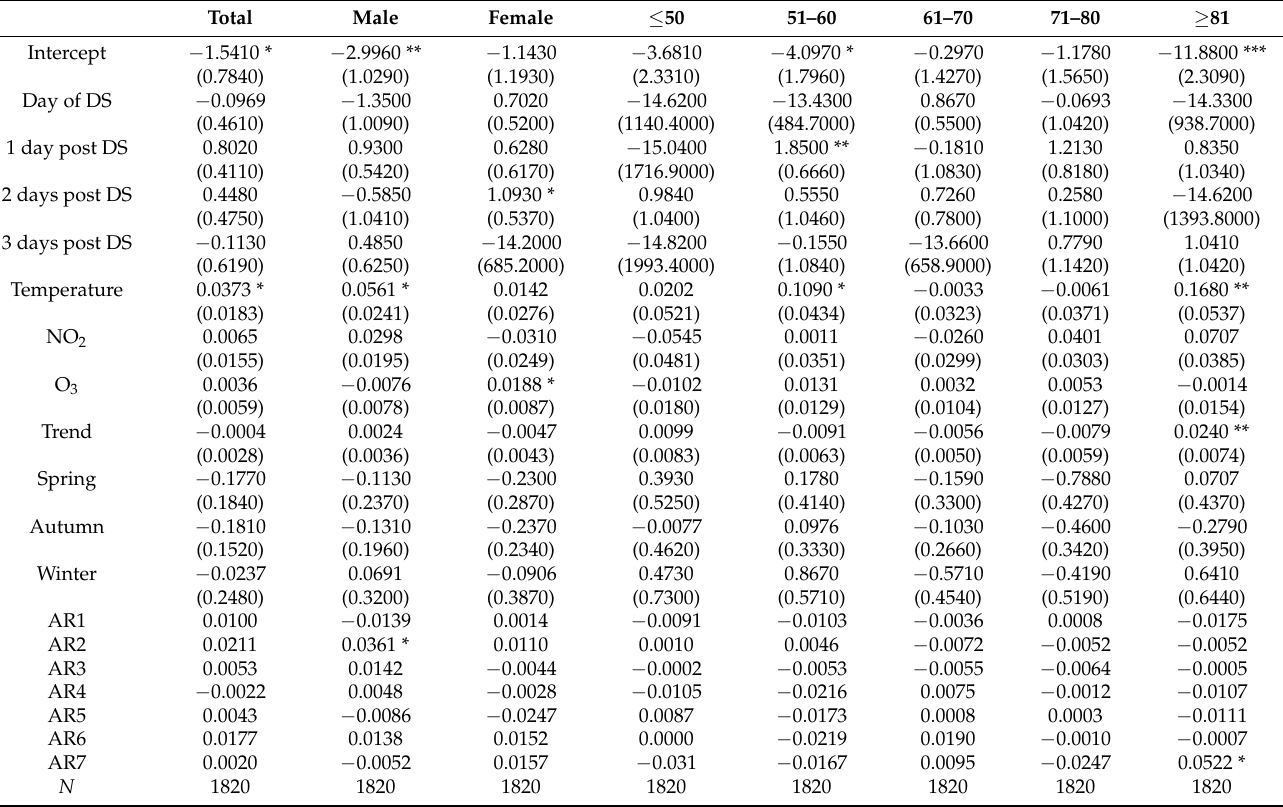
Table 5. Poisson autoregressive analysis for wet AMD inpatient care.